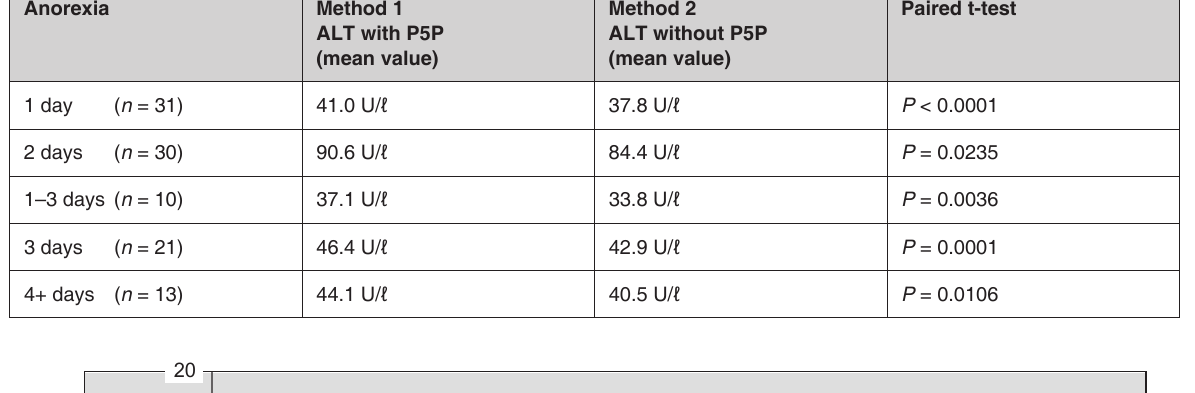
TABLE 2 Correlation between Method 1 and Method 2 and the days of anorexia in the Babesia ­infected dogs Anorexia